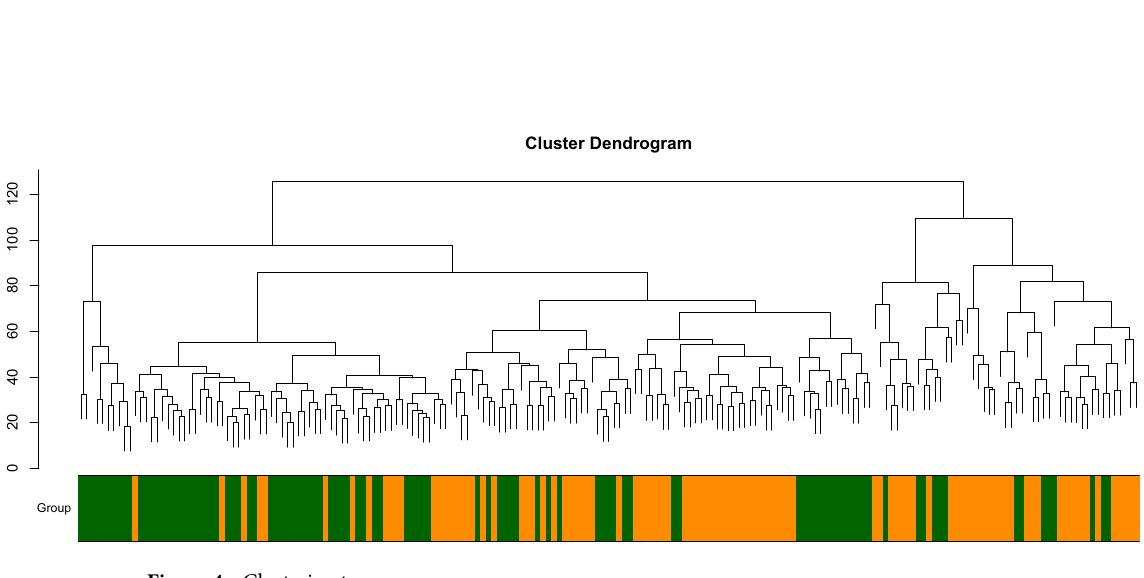
Figure 4. Clustering